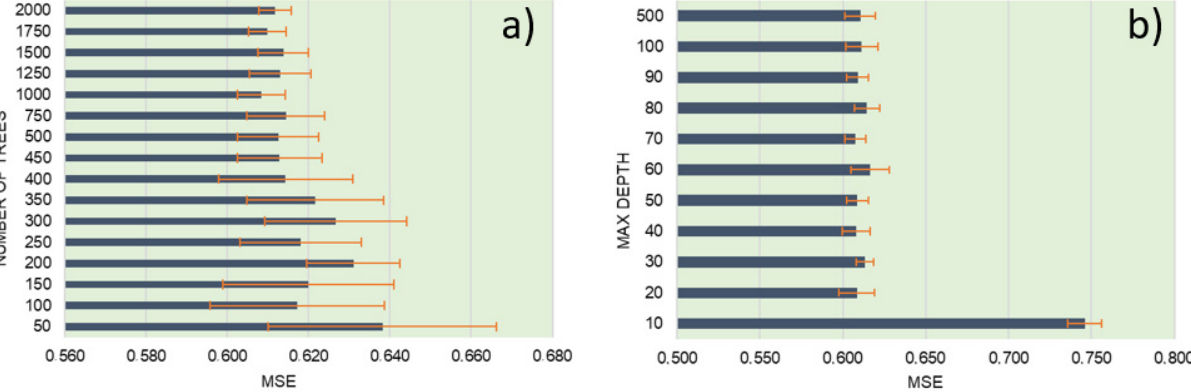
Figure 3. Mean square error (MSE) as a function of number of trees ( a ) and maximum depth ( b ) [28].